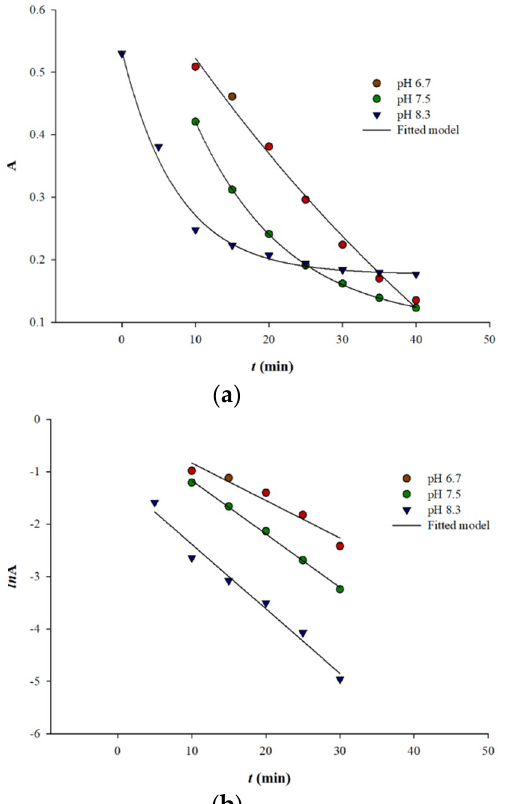
Figure 3. Effect of pH on the kinetics of quercetin oxidation (33.3 µM) in the presence of 66.6 µM of Cu 2+ ( a ) and verification of pseudo first-order kinetics shown by linear plots ( b ). Reactions were performed in the presence of 40 µM L ‐ascorbic acid and T = 70 °C.